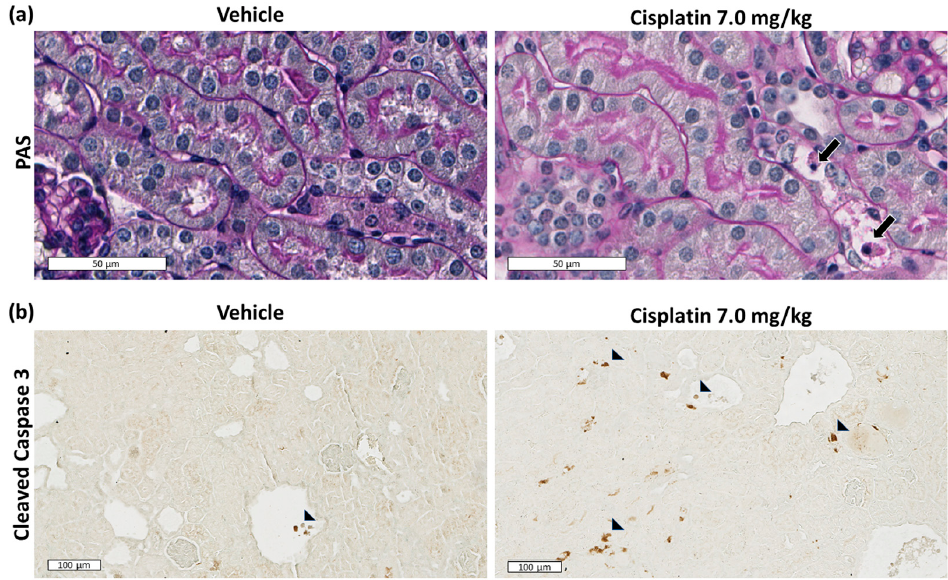
Figure 2. Apoptosis in cisplatin treated Pkd1 RC/RC /Atm +/ − mice. ( a ) Periodic acid Schiff (PAS) staining of cortical kidney sections showing apoptotic cells in non-cystic tubules (arrows) in cisplatin treated mice (Scale bars = 50 µm); ( b ) Immunohistochemical staining for cleaved caspase 3 showing positive nuclei (arrowheads) that are increased focally in non-cystic tubules of cisplatin treated mice (Scale bars = 100 µm).